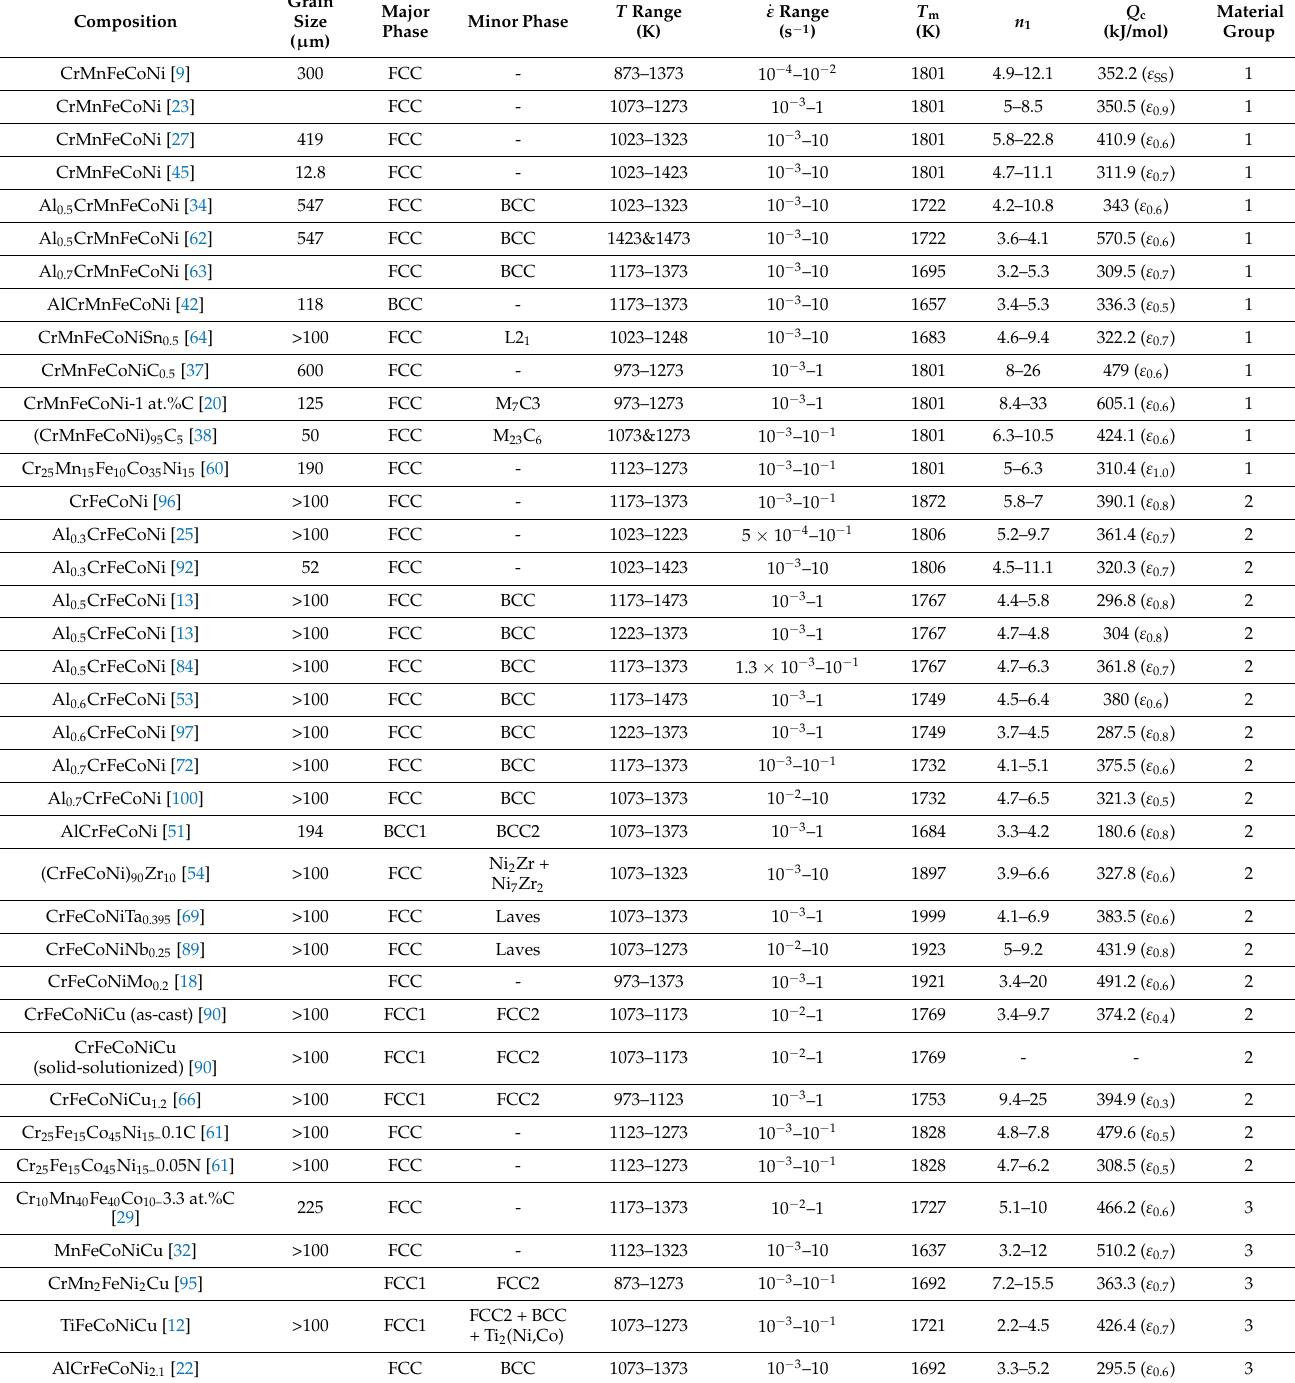
Table 1. Information regarding the chemical compositions of the HEAs, grain sizes, crystal structure, types of phases, temperature and strain rate ranges for hot compression